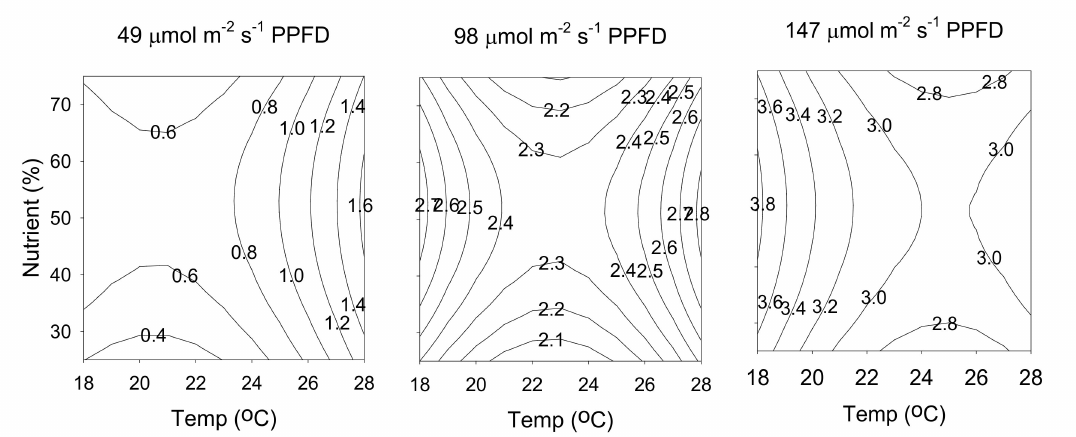
Figure 7. Contour plots of rutin content. The numbers inside the contour plots indicate content (mg / g) at given cultivated